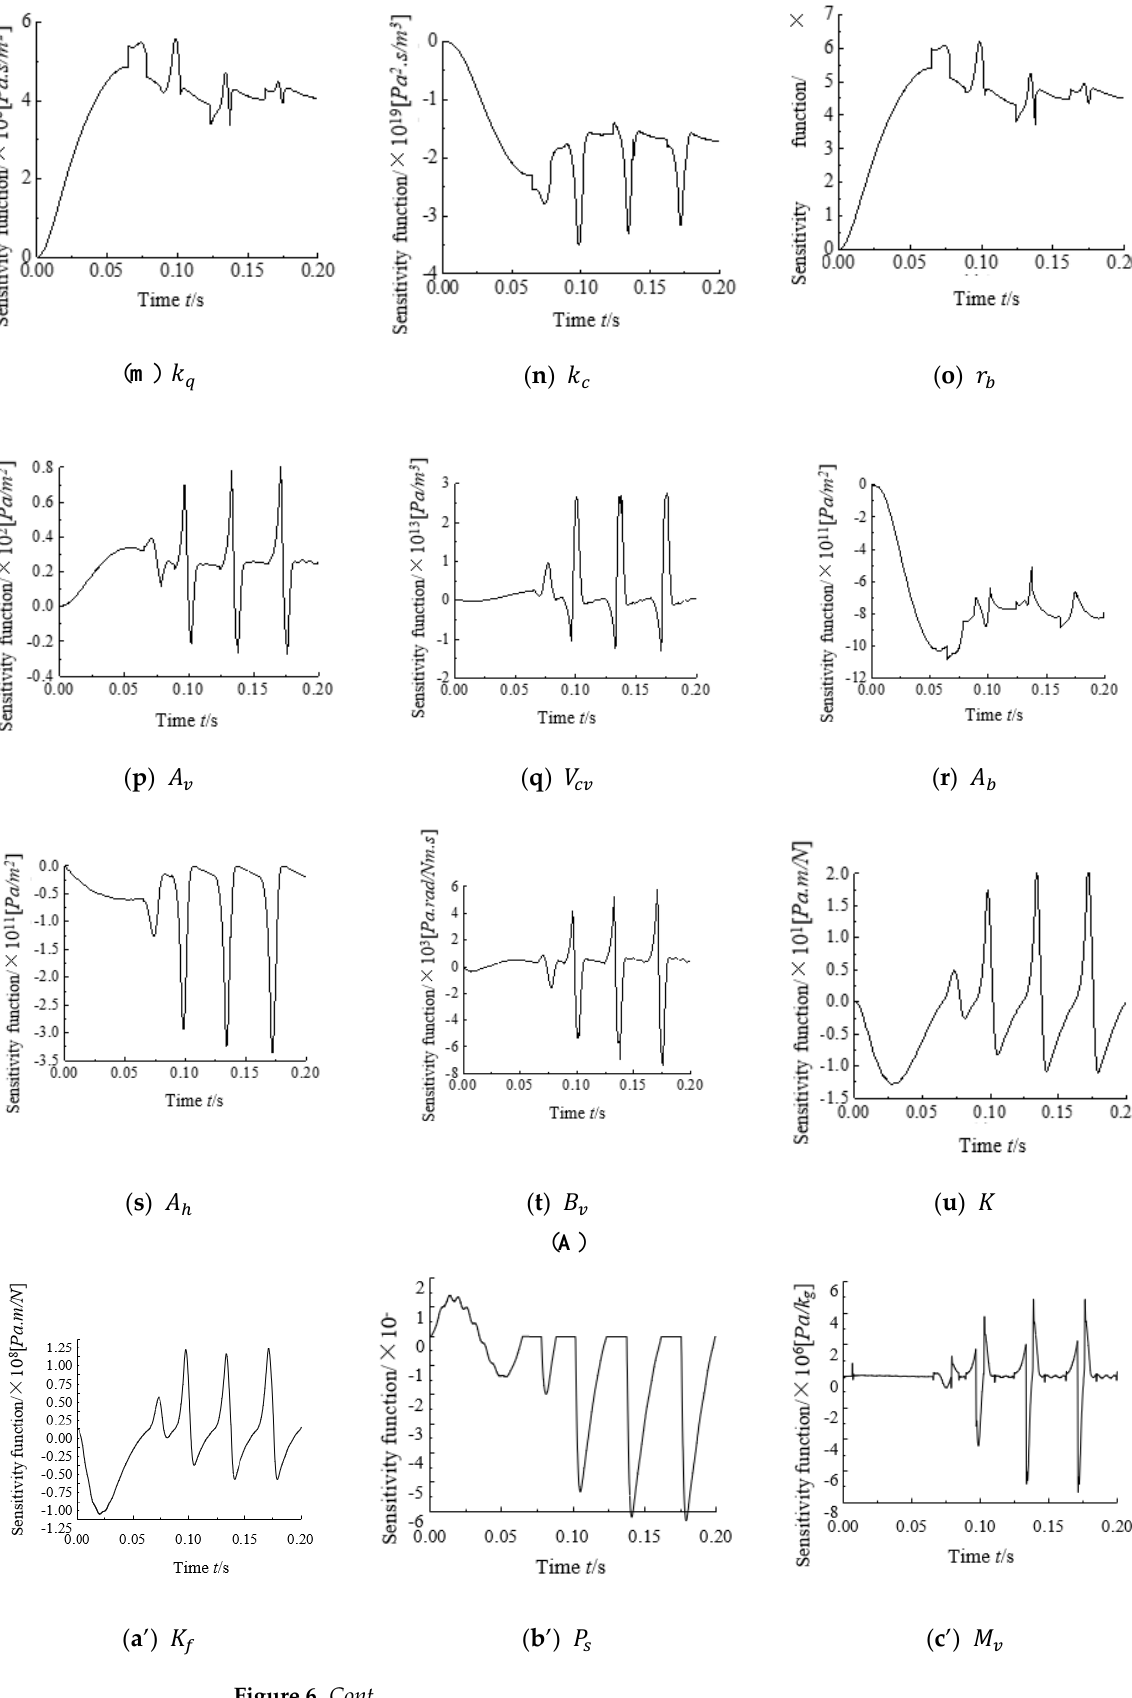
𝑀𝑀 𝑣𝑣 Figure 6. Cont